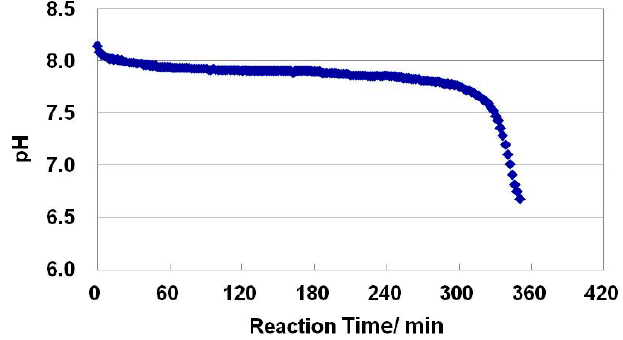
Figure 1. The change in pH of the slurry during the carbonation of Ca(OH) 2 at 70 °C with the approximate flow rate of 900 mL/min of CO 2 (30%)-clean air (70%) mixed gas for 100 g of Ca(OH) 2 , as the function of reaction time.